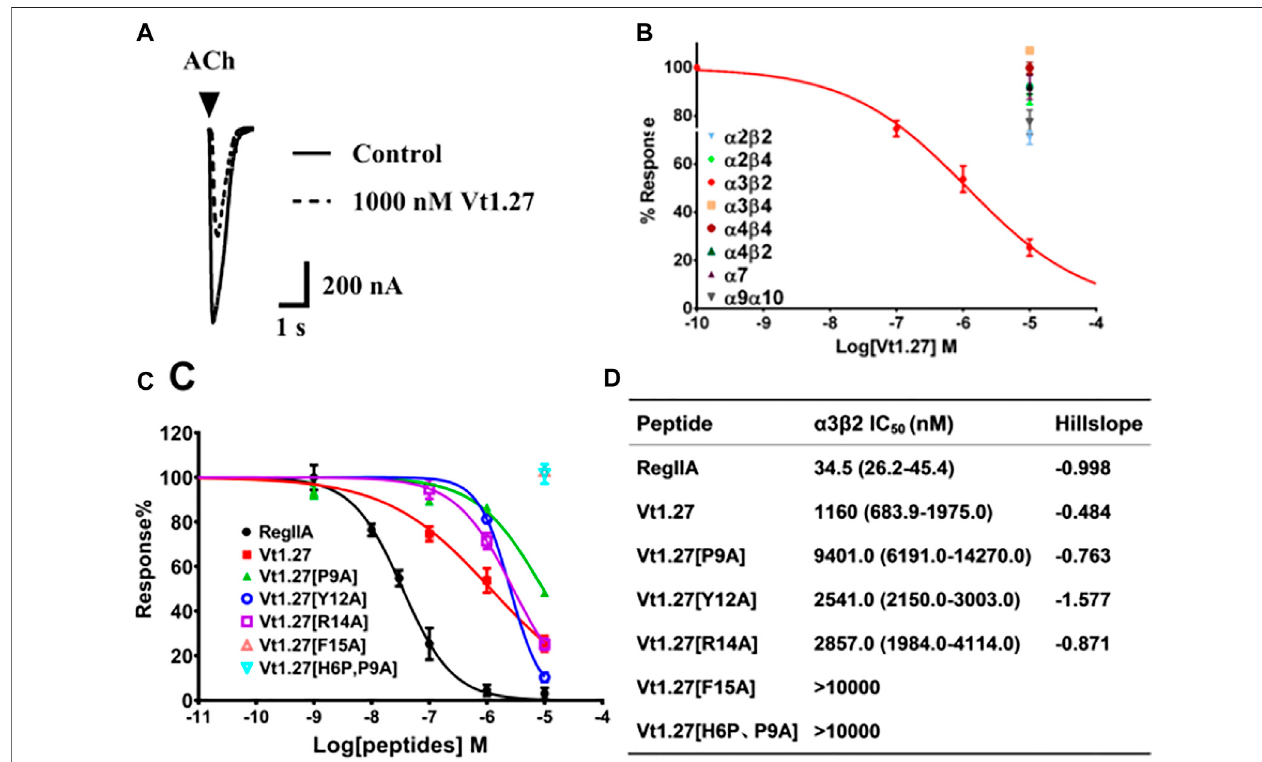
FIGURE 3 | Activity of Vt1.27 and its variants at rat nAChR subtypes expressed in Xenopus oocytes. (A) Representative superimposed ACh-evoked currents recorded from oocytes expressing α 3 β 2 nAChRs in the absence (control) and presence of Vt1.27. (B) Concentration-response relationships obtained for Vt1.27 inhibition of various rat nAChR subtypes. (C) Concentration-response curves for the inhibition of α 3 β 2 nAChR by Vt1.27 variants. Peptides were applied by perfusion to oocytes expressing nAChRs as described in Materials and Meth ods. (D) Summary of IC 50 ’ s obtained for RegIIA, Vt1.27 and analogues at rat α 3 β 2 nAChRs. Numbers in parentheses indicate 95% con fi dence intervals. n = 4 – 6